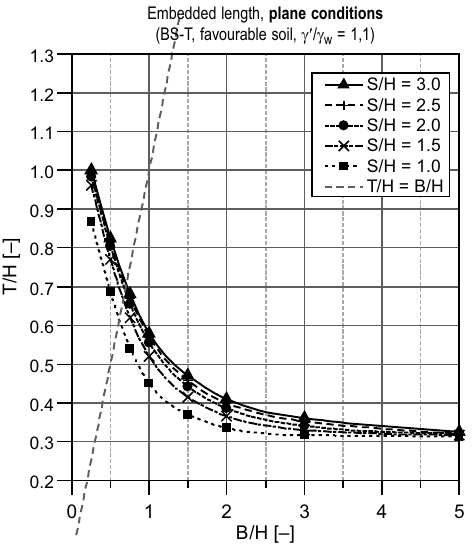
Fig. 3. Design chart for homogenous, isotropic and favourable soil under plane conditions